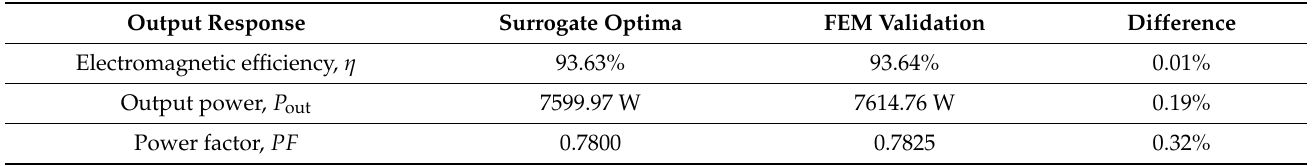
Table 6. Validation of surrogate optimal solution of the proposed optimization routine (part 1—surrogate optimization) with FEM simulation 3-variable optimization